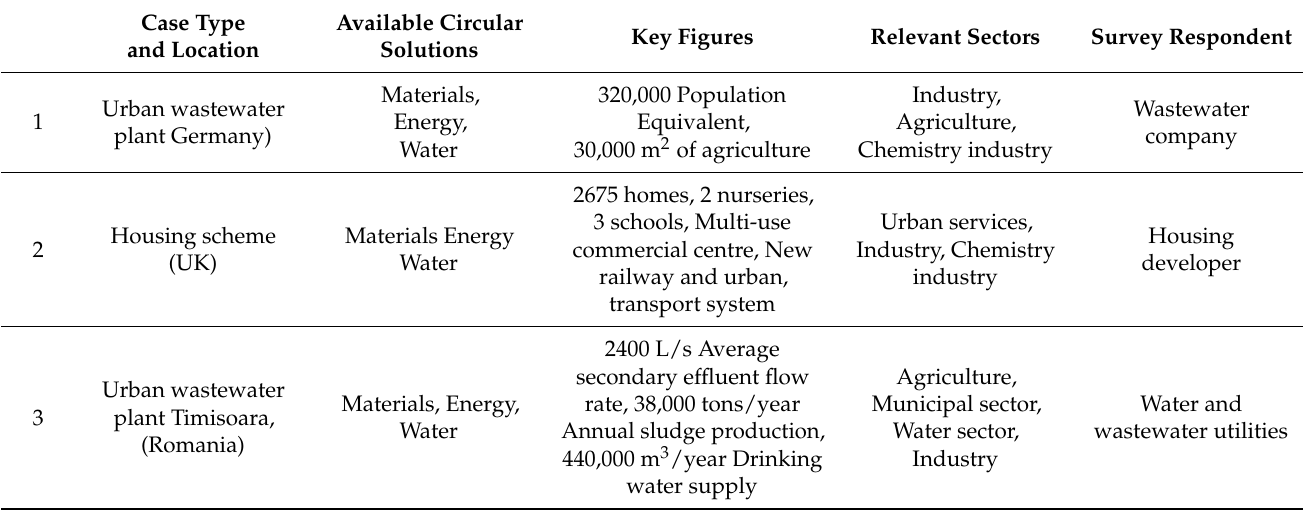
Table 2. Overview of the sampled NextGen case studies used in this